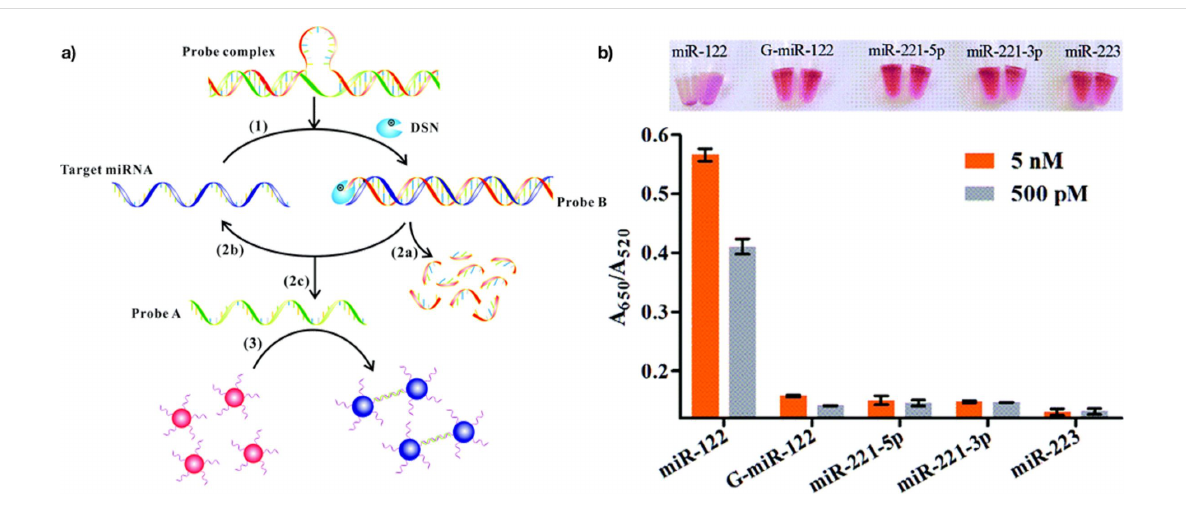
Figure 8: Schematic illustration of the colorimetric method for the detection of specific miRNA based on the amplification of DSN-assisted nanoparti- cles using AuNPs as the signal output. Reprinted with permission from [104], copyright 2015 Royal Society of Chemistry.